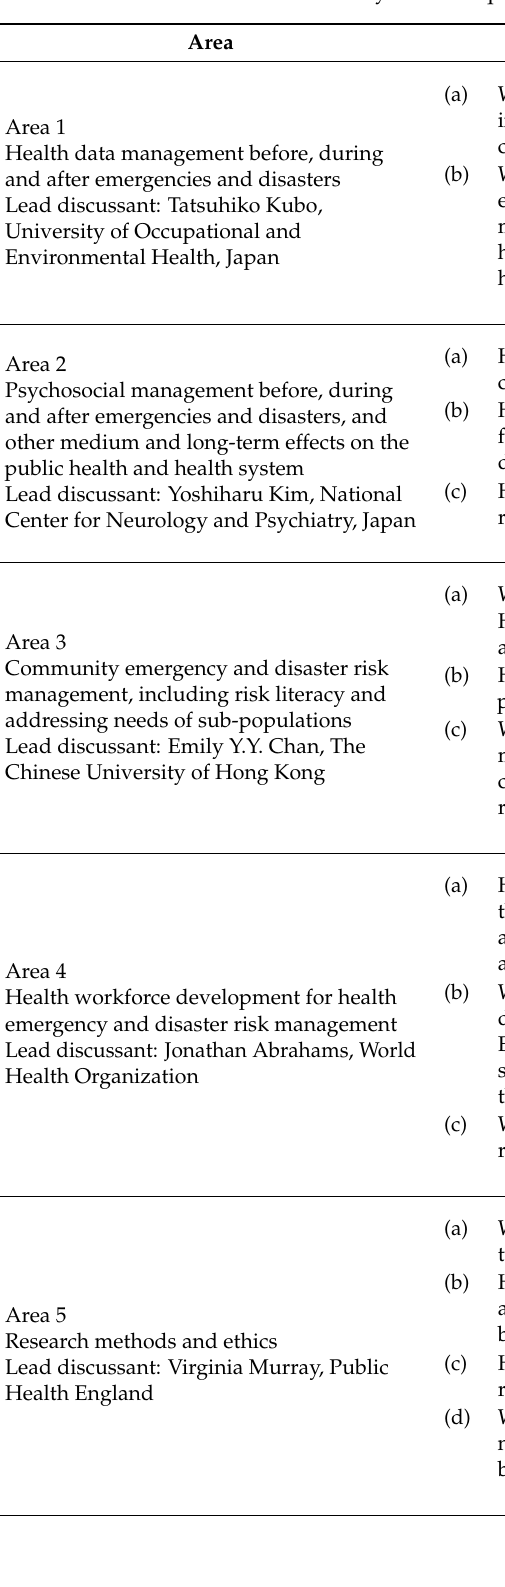
Table 1. Key research questions in five major